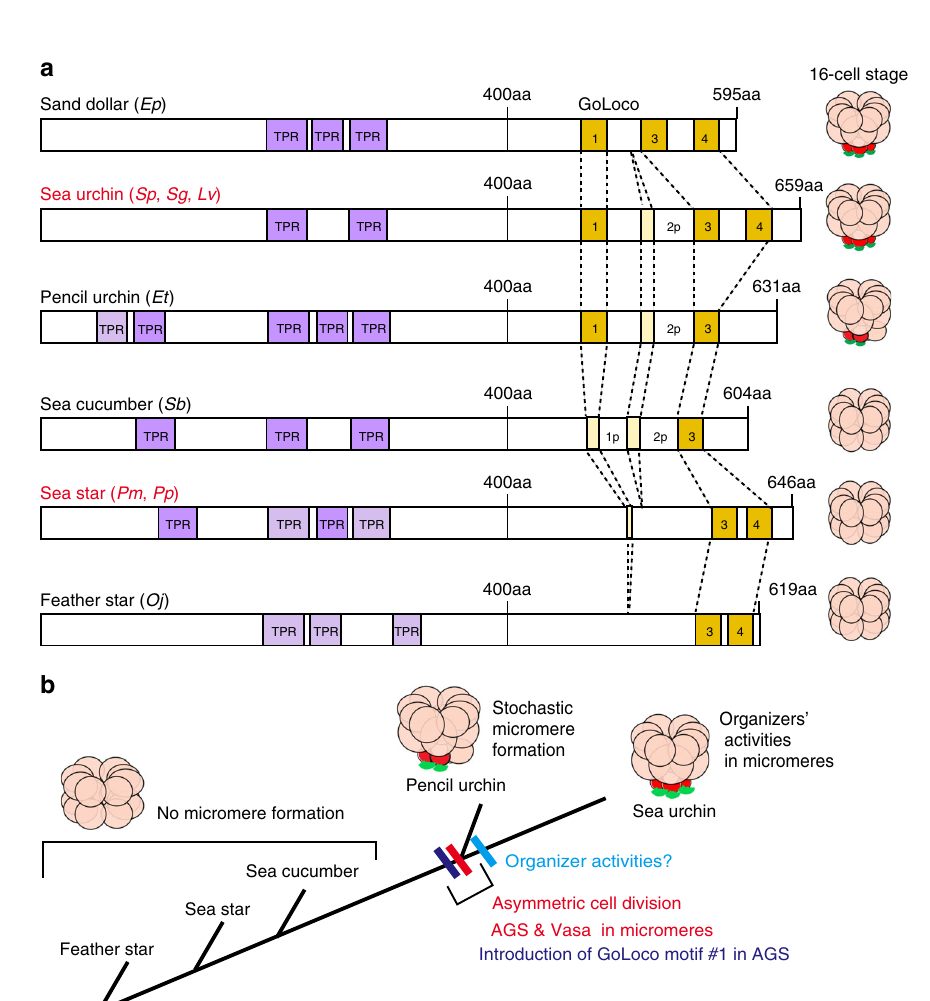
Fig. 8 SpAGS-overexpression induces endo-mesodermal lineages in sea star embryos. a – c 1.5 μ g/ μ l stock of SpAGS-GFP mRNA was injected into unfertilized eggs and the micromere-like cells were labeled with red fl uorescent dextran (dye) during 8 – 32 cell stage ( a ). At Day 2, embryos were scored for each category based on where the dye signal was found ( b , c ). Arrows indicate the signal enrichment at the bottom of the gut. At the occasion when the signal was scattered in various tissues, the embryo was counted for each category. n indicates the total number of embryos scored. d – g 0.75 μ g/ μ l stock of SpAGS-GFP mRNA or dye was injected into one of the blastomeres at the 8-cell stage ( d ). At Day 2 ( e ), embryos that were injected with dye ( f ) or with dye and SpAGS-GFP mRNA ( g ) were scored for each category based on where the dye signal was found. When the signal was scattered in various tissues, the embryo was scored in each lineage category. In e , arrow indicates AGS-GFP enrichment at the vegetal-most region of the gut and arrowheads indicate the signal enrichment of extra invaginations. n in the graphs f – g indicates the total number of embryos scored. Each experiment was performed at least three independent times. Each image shows the representative phenotypes scored in the corresponding graph. Scale bars = 50 μ m